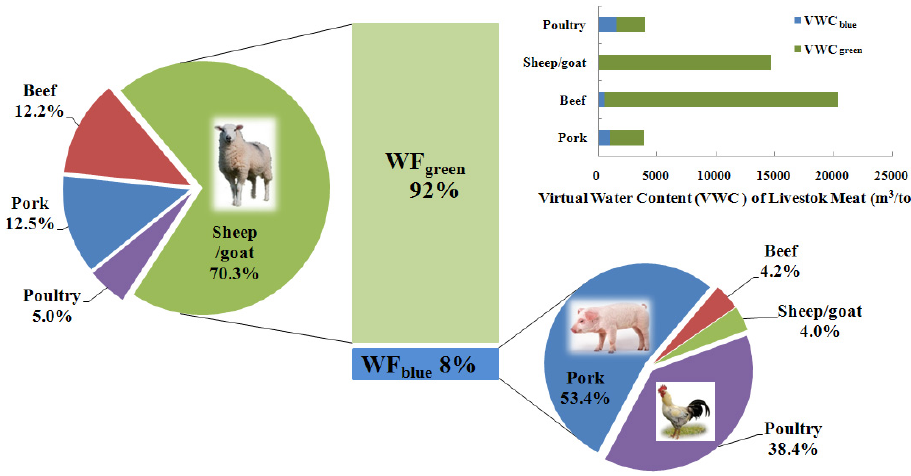
Fig. 5. Green and blue water footprint (WF green and WF blue ) of livestock production within the HRB over 2004–2006.